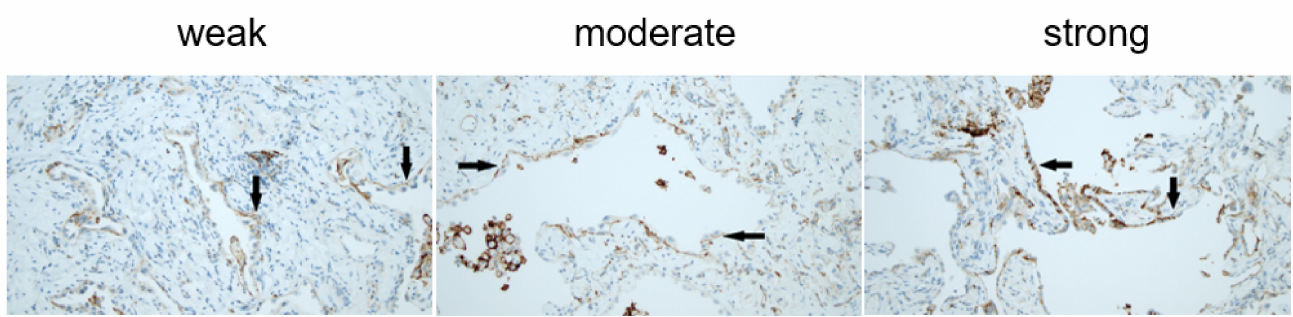
Figure 1. Membranous PD-L1 expression in parenchymal epithelial cells. PD-L1 expression in epithelial cells (arrows). Macrophages are positive and represent an internal control. Medium